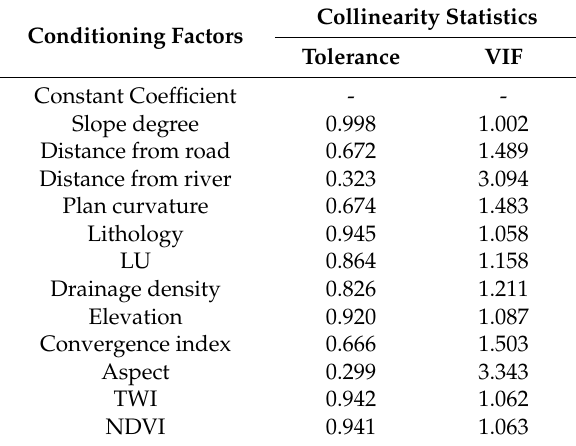
Table 2. Multi-collinearity of effective factors using tolerance (TOL) and variance inflation factor (VIF).